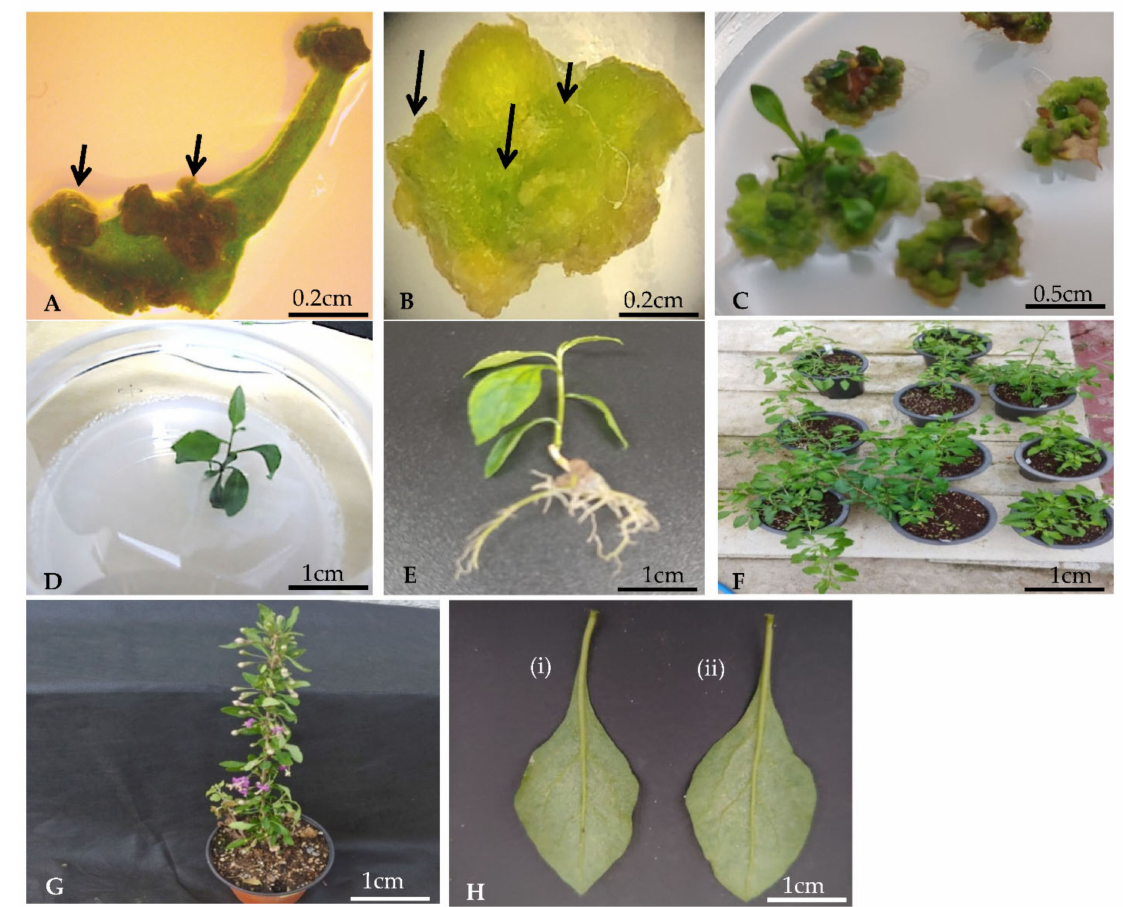
Figure 1. In vitro regeneration of Lycium chinense via direct shoot organogenesis. ( A ) Shoot bud initiation (arrows head) from the basal end of petiole explants after 2 weeks of culture on Murashige and Skoog (MS) medium supplemented with 0.5 mg/L thidiazuron (TDZ) (bar = 0.1 cm). ( B ) Regeneration of multiple shoots from leaf explants after three weeks of culture on MS supplemented with 0.5 mg/L TDZ (bar = 1 cm). ( C ) Well-developed elongated shoots after eight weeks of culture on MS supplemented with 0.5 mg/L TDZ (scale bar = 0.5 cm). ( D ) Rooting of regenerated shoots after four weeks of culture on MS supplemented with 1 mg/L indole-3-butyric acid (IBA) (bar = 1 cm). ( E ) A plantlet with a well-developed root system (bar = 1 cm). ( F ) Acclimatized plantlets growing in a greenhouse in pots containing a 3:1 mixture of sterilized vermiculite and perlite. ( G ) Flowering of acclimatized L. chinense plants in greenhouse conditions. ( H ) Leaf of (i) in vitro regenerated plant, (ii) leaf of donor